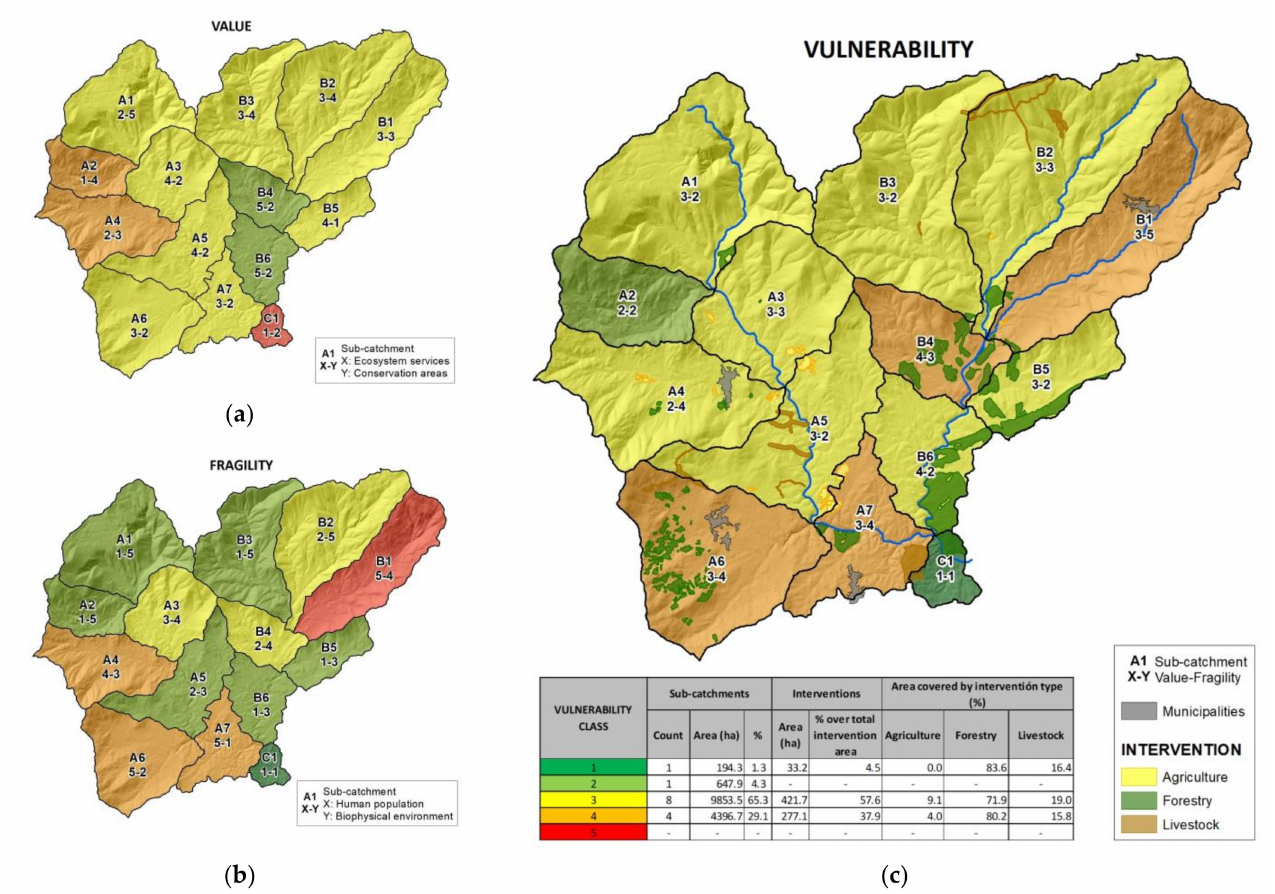
Figure 4. Vulnerability and its components by sub-catchment at the study site: ( a ) value; ( b ) fragility; ( c )